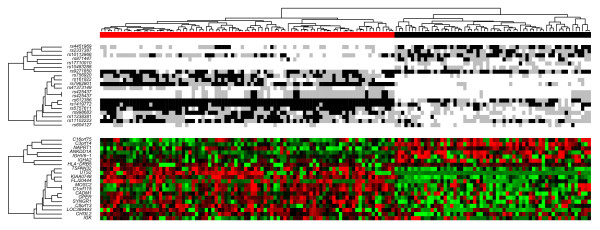
Heatmap of hierarchical clustering. The vertical hierarchical cluster shows that the CEU (black) and Asian (red) populations can be separated by clustering their genotypes as shown in the horizontal hierarchical tree. Upper heatmap: black shading represents individuals homozygous for the upregulated allele, and gray shading represents heterozygous. White shading indicates individuals homozygous for the downregulated allele. The lower heatmap represents expression of the genes corresponding to the eSNPs in the upper heatmap; intensity of red is proportional to degree of expression above the mean, and intensity of green is proportional to degree of expression below the mean.